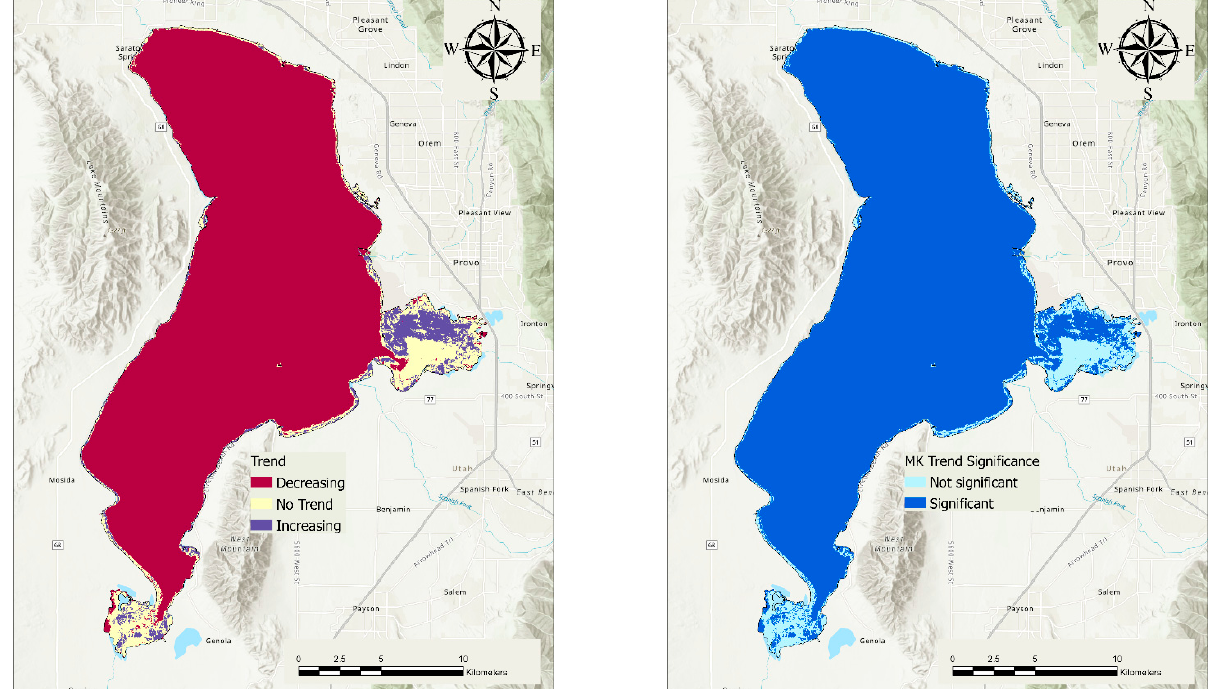
Figure 9. A map showing whether chl-a concentration trends are increasing or decreasing ( left panel ), areas with no trend are blank (white), while the right panel shows if the trends are statistically significant.